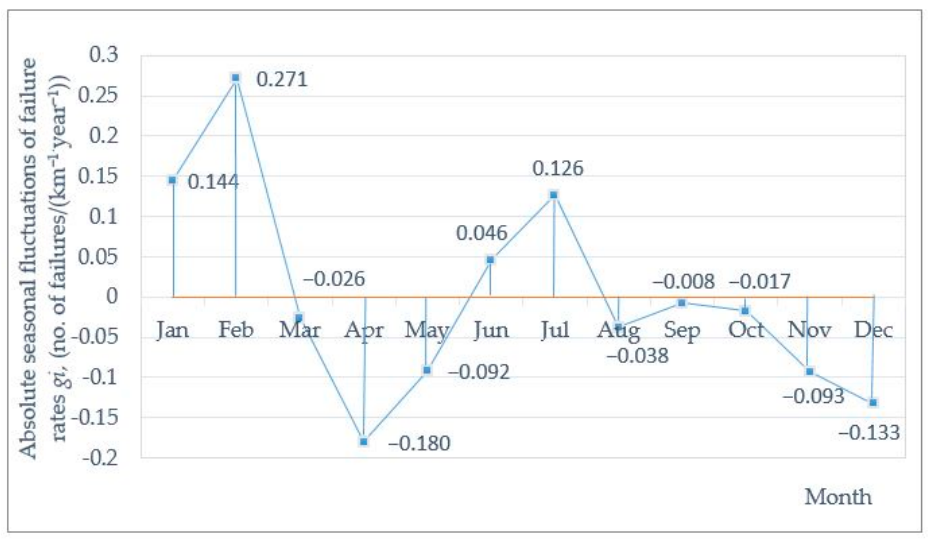
Figure 8. Absolute seasonal fluctuations of failure rates in WDN, in (no. of failures/(km − 1 · year − 1 )).